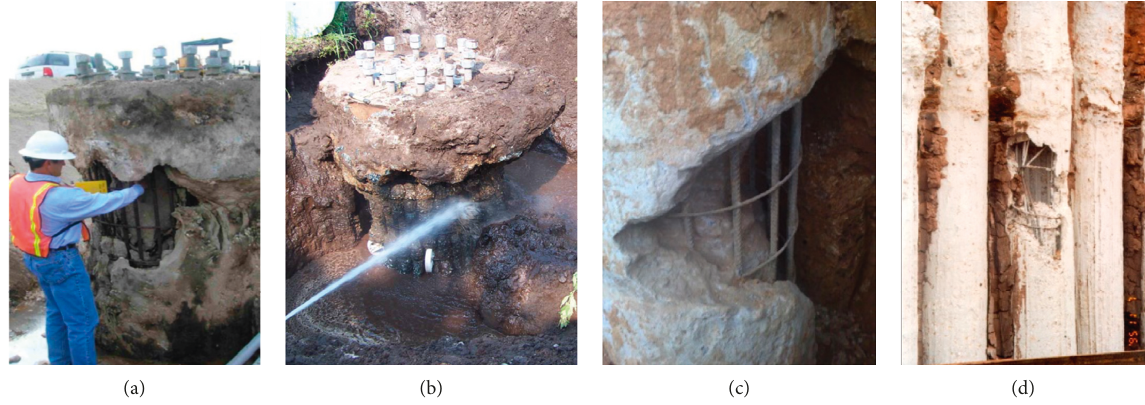
Figure 1: Different kinds of defects (images are from an online